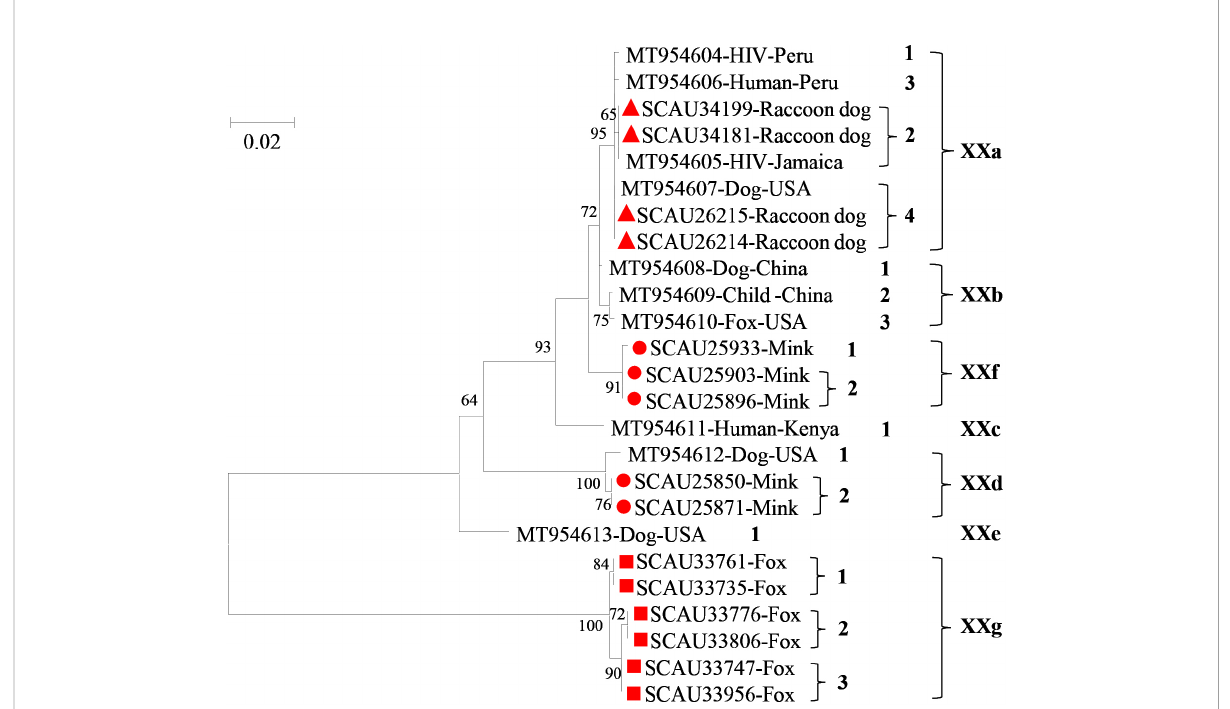
FIGURE 2 Phylogenetic relationship among seven Cryptosporidium canis subtype families (XXa-XXg) based on the maximum likelihood analysis of the partial gp60 gene using the general time-reversible model for the calculations of substitution rates. Bootstrap values greater than 50% from 1,000 replicates are displayed. Samples detected in minks, raccoon dogs and foxes from this study are indicated with red circles, triangles, and squares,